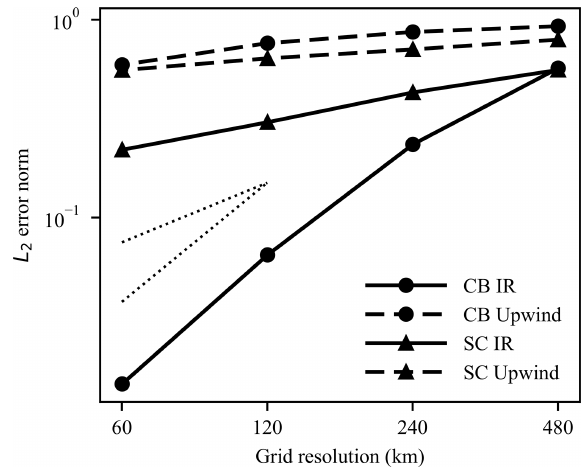
Figure 17. Scaling of the L 2 error norm with grid resolution for the cosine bell (CB) and slotted cylinder (SC) advection tests shown in Fig. 15. IR scaling is shown by the solid lines, upwind by long- dashed lines. Theoretical linear and quadratic scaling are shown by short-dashed